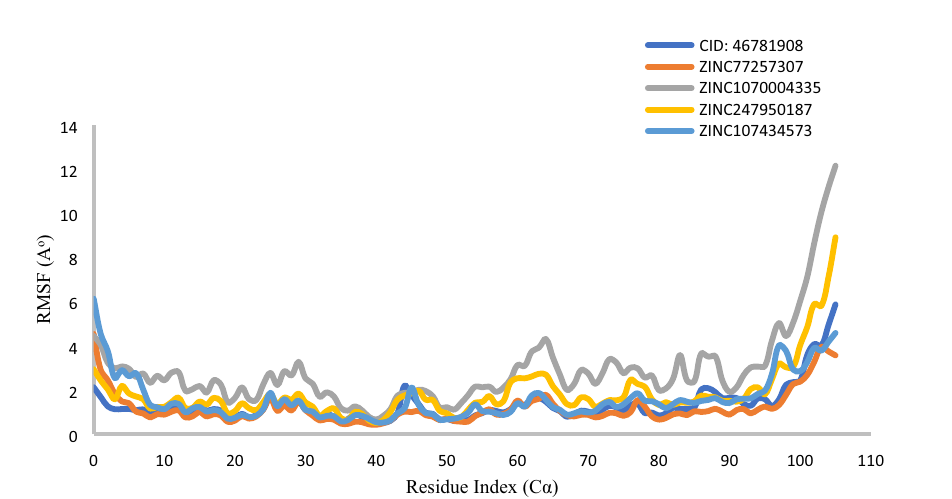
Figure 10. RMSF values extracted from protein Cα atoms, viz CID: 46781908 (Gray), ZINC77257307(orange), ZINC1070004335, ZINC247950187 (Gold), ZINC107434573 (Blue), with respect to 50 ns simulation